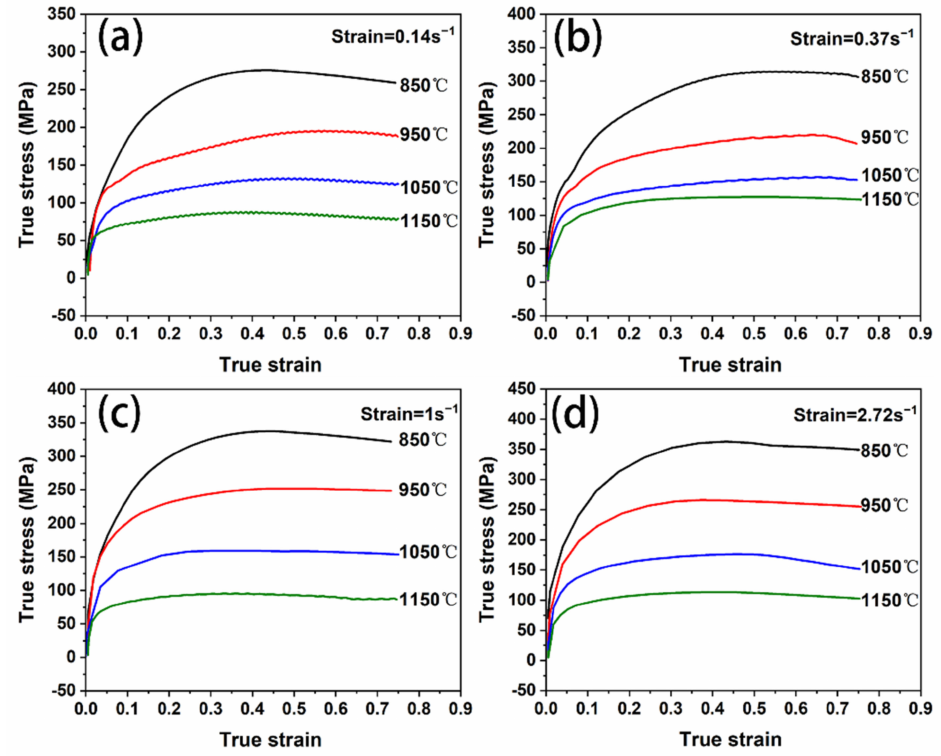
Figure 2. Typical true strain–stress curves of the alloy under different deformation temperatures and strain rates, ( a ) 0.1 s − 1 , ( b ) 0.37 s − 1 , ( c ) 1 s − 1 , and ( d ) 2.271 s − 1